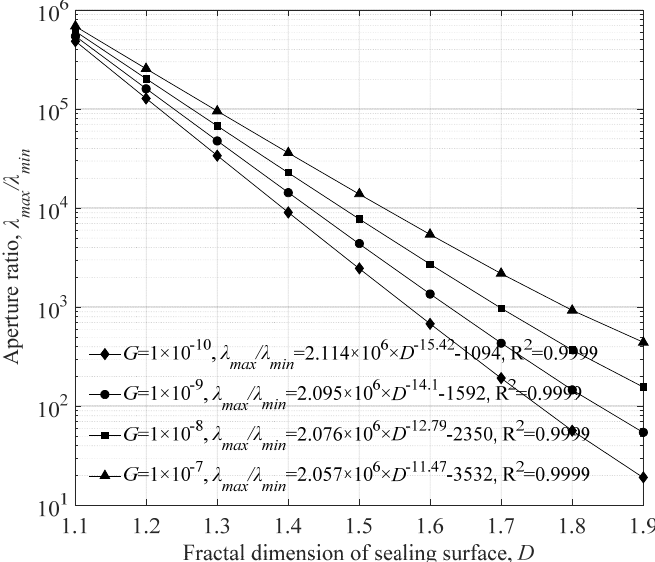
Figure 13. The influence of the sealing surface fractal parameters on the aperture ratio.